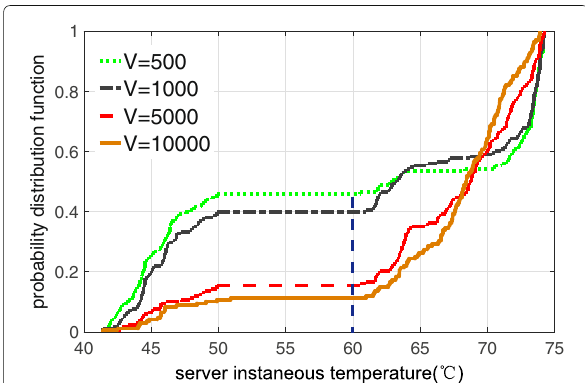
Fig. 15 The probability distribution function of server instantaneous temperature under linear policy vs. V